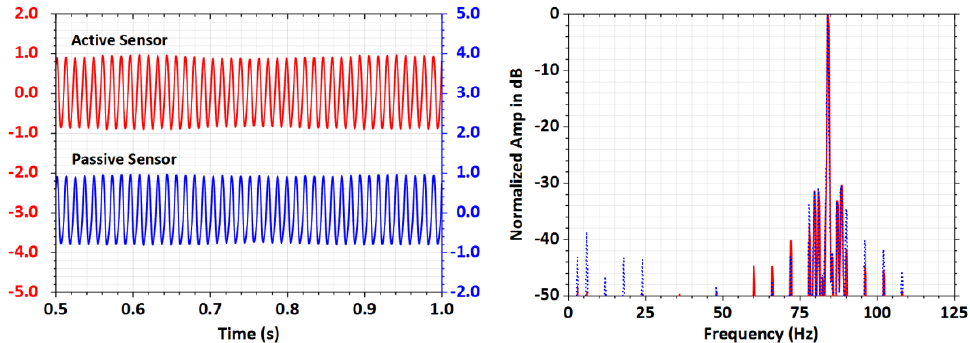
Figure 17. Outputs of a healthy rotor without any defects.